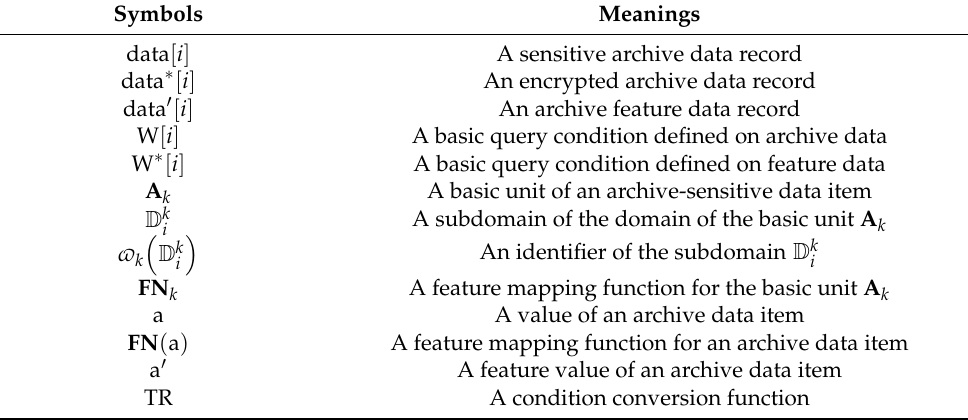
Table 2. Symbols and their